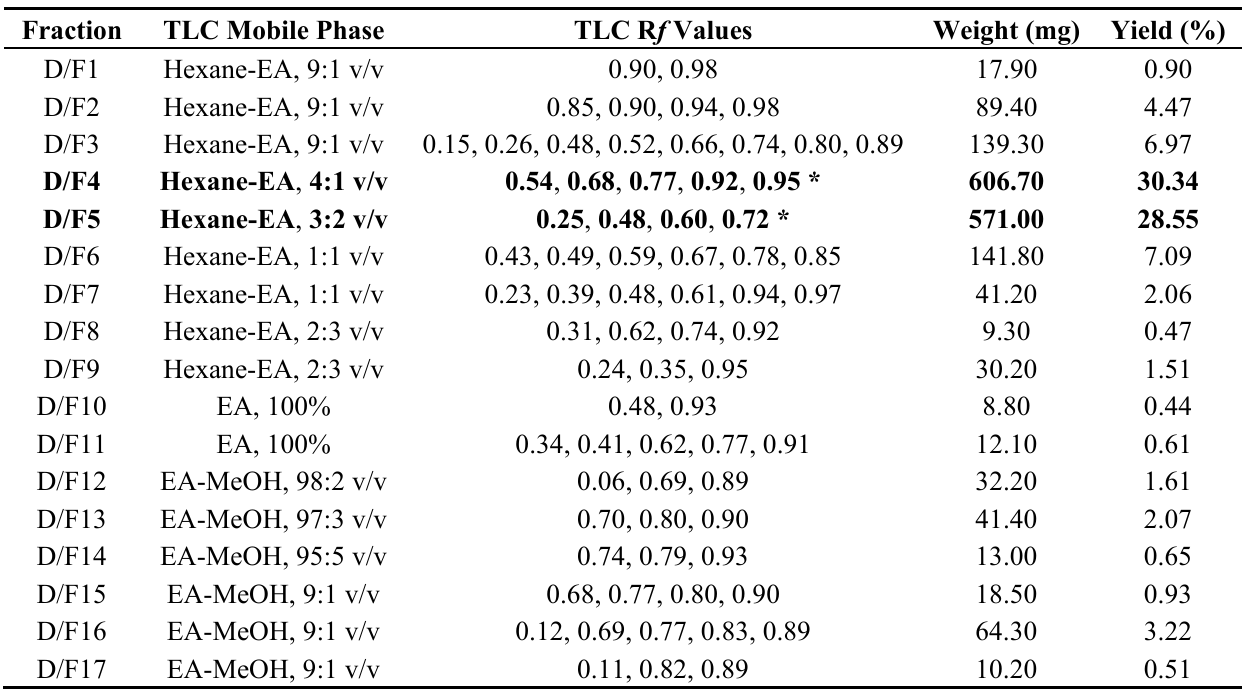
Table 1. Yield of DCM fractions of D. suffruticosa